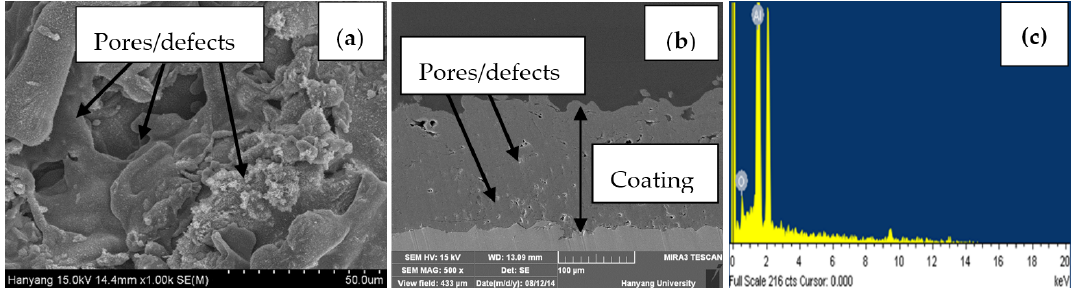
Figure 3. SEM images ( a ) top surface, ( b ) cross section and ( c ) EDS of the Al coating by the arc thermal metal spray process.